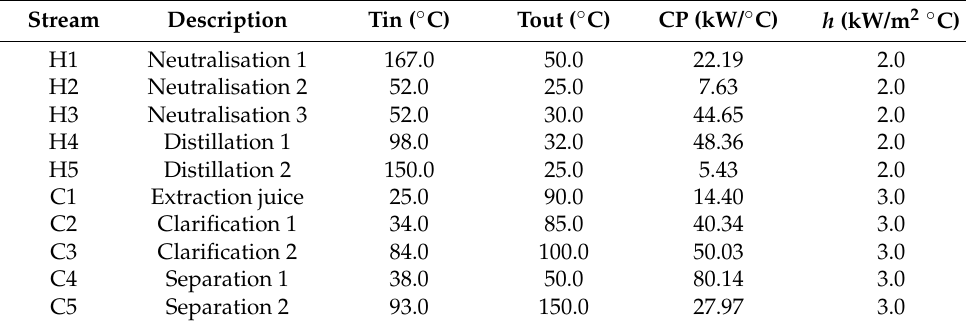
Table 2. 1G and 2G bioethanol process stream